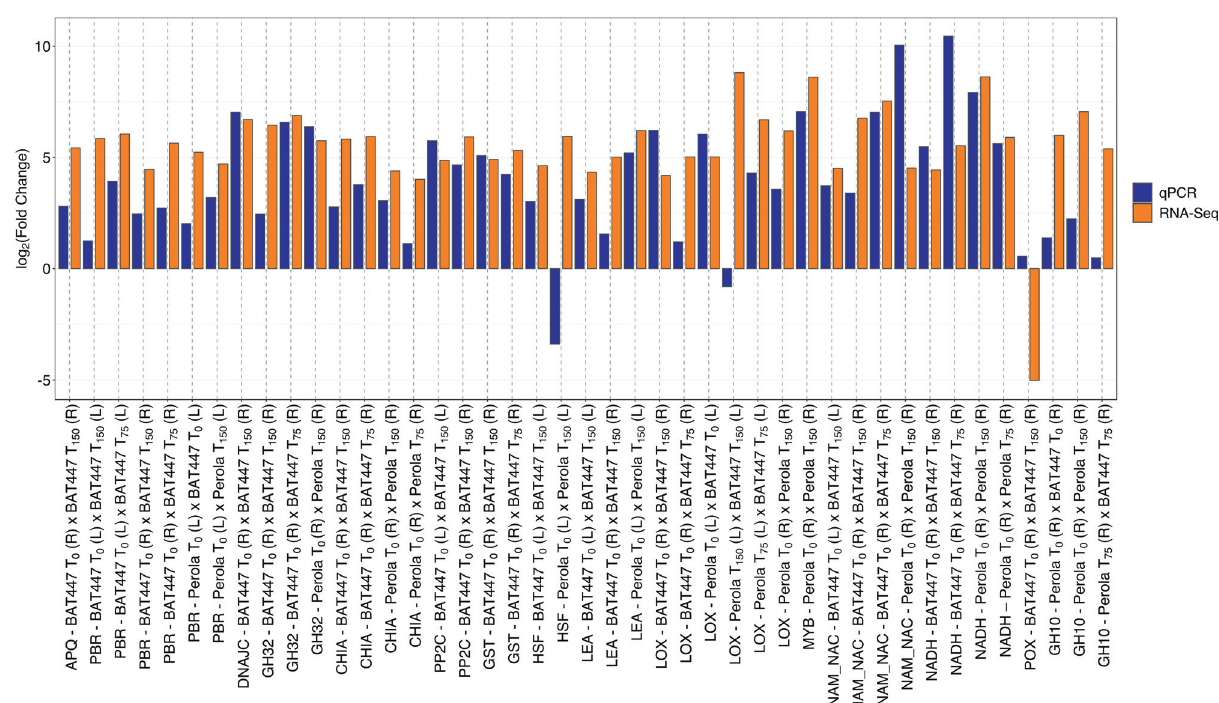
Figure 2 - Distribution of variants (SNPs and indels) in P. vulgaris chromosomes.